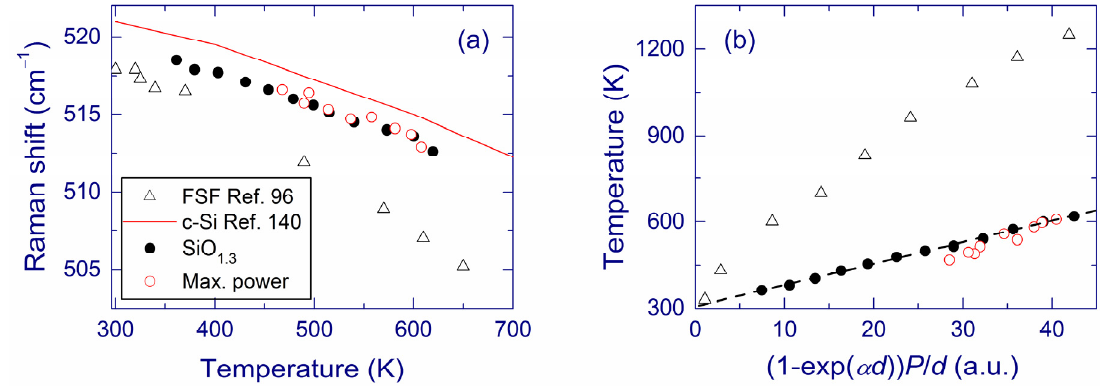
Figure 10. ( a ) Raman shift as a function of the laser-induced temperature and ( b ) Laser-induced temperature as a function of the absorbed laser power. The measurements are made for a SiO 1.3 film on a silica substrate annealed at 1100 °C using various 488-nm laser intensities (solid circles) and for SiO x films (1.3 < x < 1.5) at the maximum laser intensity of ~10 4 W cm –2 (open circles) [116]. The data for a free-standing SiO 1.7 film [95] (FSF, triangles) and for crystalline Si [139] (solid line) are shown for comparison. The dashed line in panel b is a linear fit. Reproduced with permission from [116].